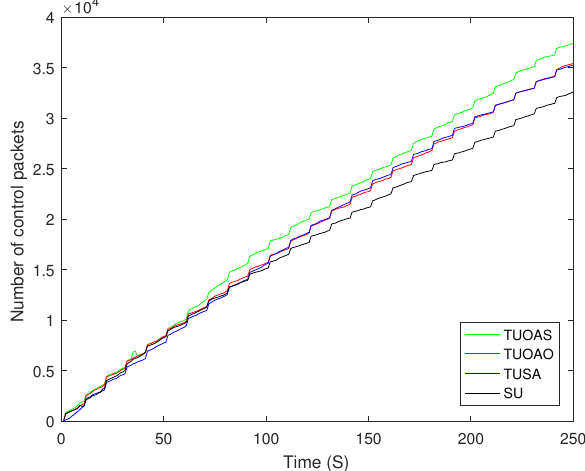
Figure 18. Number of control packets.